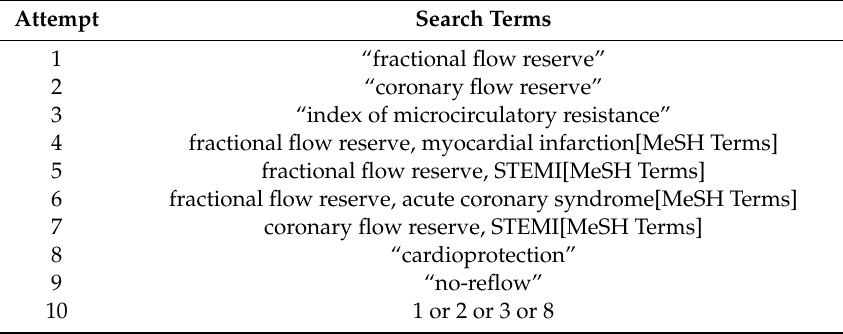
Table 1. Search Strategy Used in the PubMed and Cochrane Trial